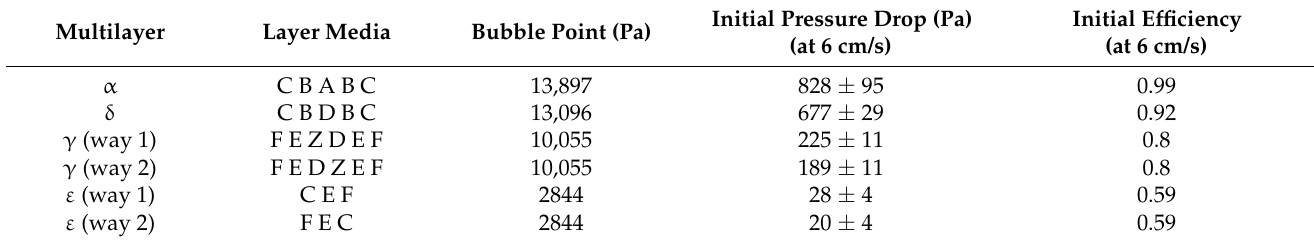
Table 3. Characteristics of different multilayer metallic media.